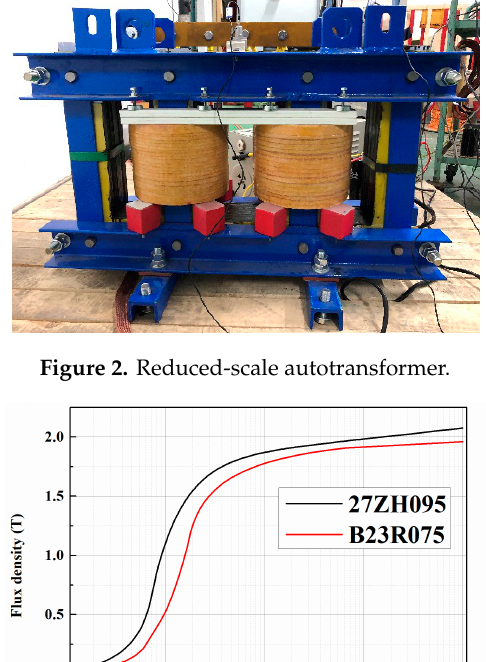
Figure 1. Experimental platform with load under DC bias. ( a ) Schematic diagram. ( b ) Photo of the experimental platform.